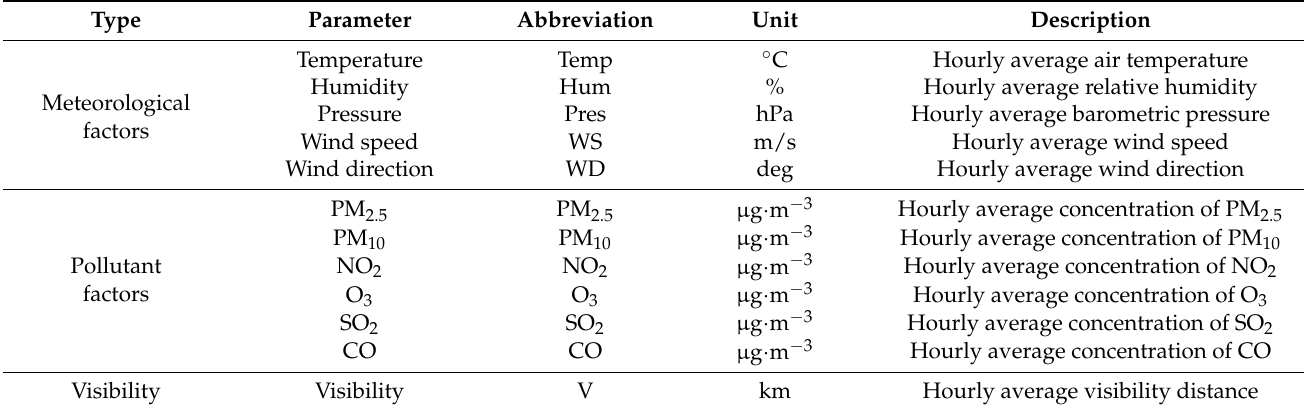
Table 1. Description of raw